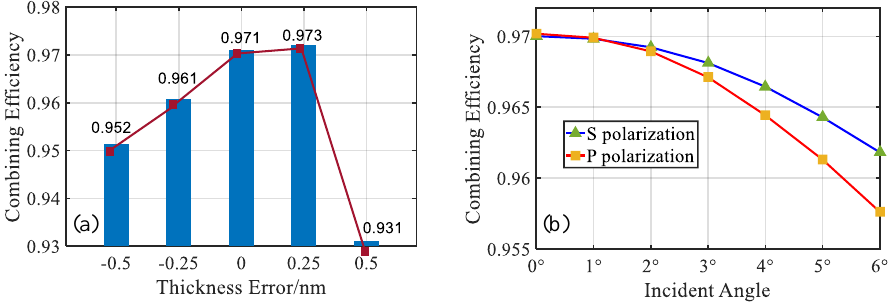
Figure 8. ( a ) The combining efficiency as a function of the thickness error. ( b ) The combining efficiency as a function of the incident angle. The blue line represents the s -polarized light, and the red line represents the p -polarized light.